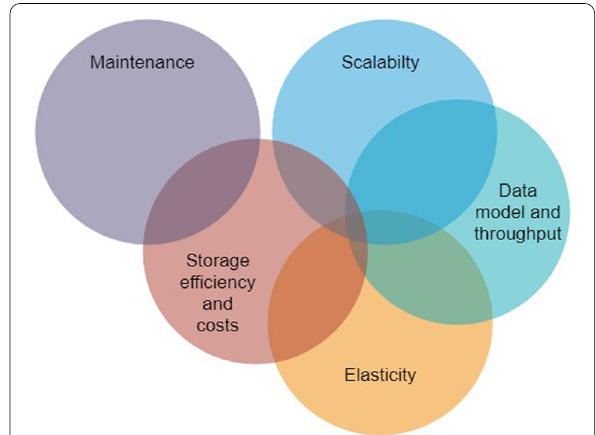
Fig. 2 Criteria chosen to evaluate database performance and their overlaps